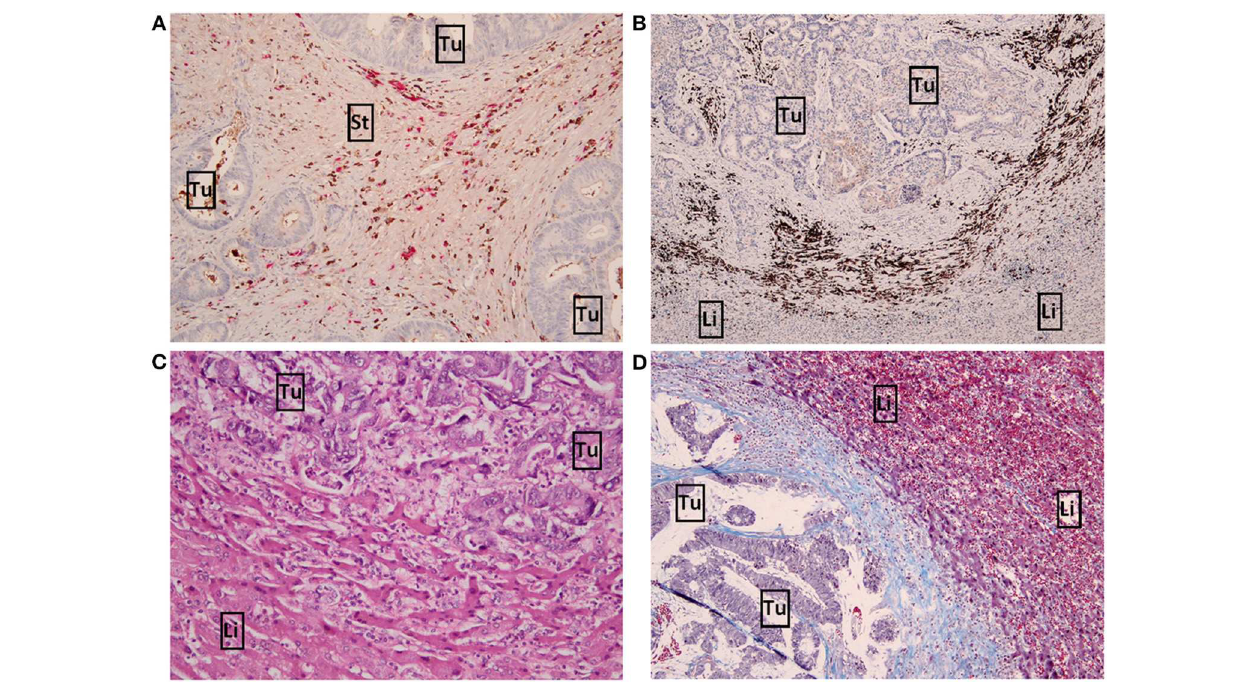
FIGURE 2 | Detailed pictures of immunohistochemistry. (A) x10 magnification image of high Kappa/Lambda + staining in the tumour stroma. Kappa light chains are stained brown, Lambda light chains are stained pink. (B) x4 magnification image of high CD79A + staining (brown) in the invasive margin. (C) x10 magnification image of a replacement growth pattern by H&E staining. (D) x10 magnification image of a desmoplastic growth pattern by Masson’s trichrome staining. Tumour and liver cells are stained purple, connective tissue (desmoplastic rim) is stained blue. Tu, tumour; Li, liver; St, tumour